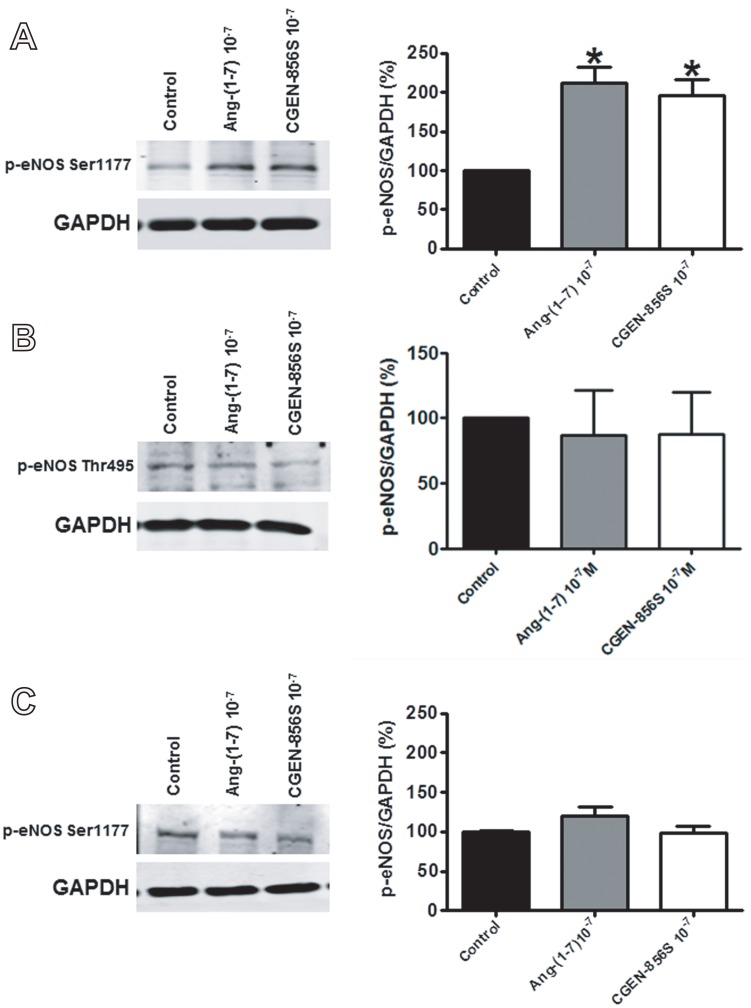
Effects of CGEN-856S and Ang-(1–7) administration on p-eNOS levels.CGEN-856S and Ang-(1–7) administration (10−7 mol/L) increased the quantity of (A) p-eNOS Ser1177, but not (B) p-eNOS Thr495 in CHO-Mas cells. (C) The absence of the effects of CGEN-856S and Ang-(1–7) administration (10−7 mol/L) on p-eNOS Ser1177 levels in CHO-K1 cells. Cells were exposed to the agonist for 10 min. Ang-(1–7) was used as a positive control and GAPDH was used as a loading control. *P<0.05 vs. control. Results are expressed as the mean ± SEM of 4−6 experiments.